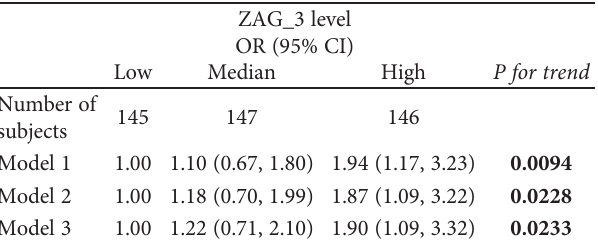
Multivariate odds ratios (OR) and 95% con fi dent intervals (CI) from unconditional logistic regression models were used in the analysis. Model 1: basic model, adjusted for age group, gender, and education. Model 2: further adjusted for BMI ( < 24kg/m 2 , ≥ 24kg/m 2 ), WC ( < 90cm, ≥ 90cm) in men and ( < 85cm, ≥ 85cm) in women, hypertension (none, yes), TC ( < 5.2mmol/L, ≥ 5.2nnol/L), TG ( < 1.7mmol/L, ≥ 1.7mmol/L), HbA1 ( ≤ 7.0%, > 7.0%), FPG ( ≤ 7.0mmol/L, > 7.0mmol/L), based on C Model 1. Model 3: full model, further adjusted for uACR ( < 2.7mg/mmol, ≥ 2.7mg/ mmol) and 25OHD ( > 50 nmol/L, ≤ 50nmol/L) based on Model